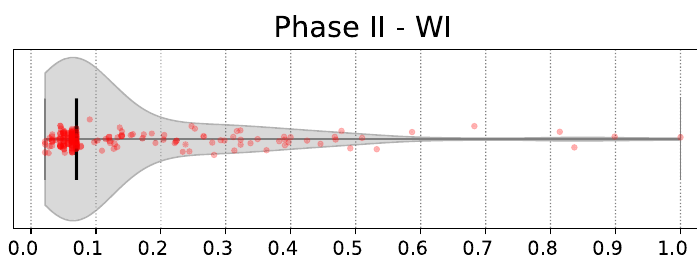
Figure 6: WI distribution of Dunaújváros Phase II ( c. 1950 – 1650 BCE ) . Bold black bar indicates the